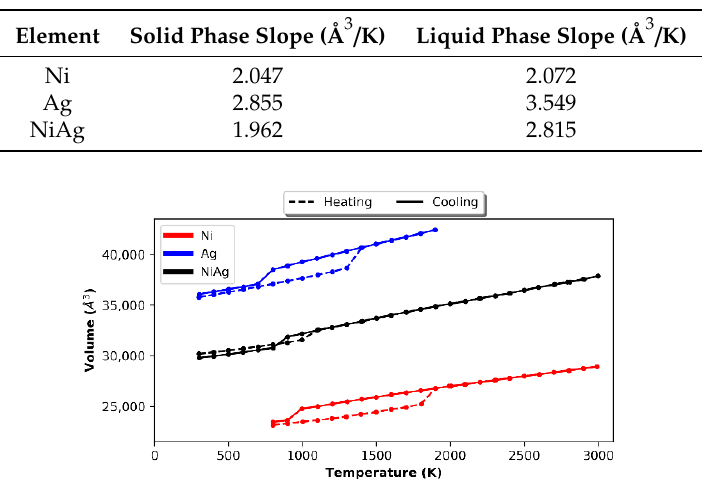
Figure 2. Melting and cooling of a 2048 atom sample of Ni ( red ), Ag ( blue ), and NiAg ( black ).